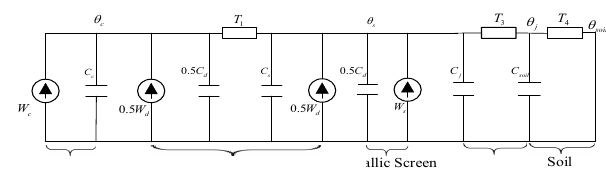
Fig. 1. Equivalent thermal circuit of the XLPE